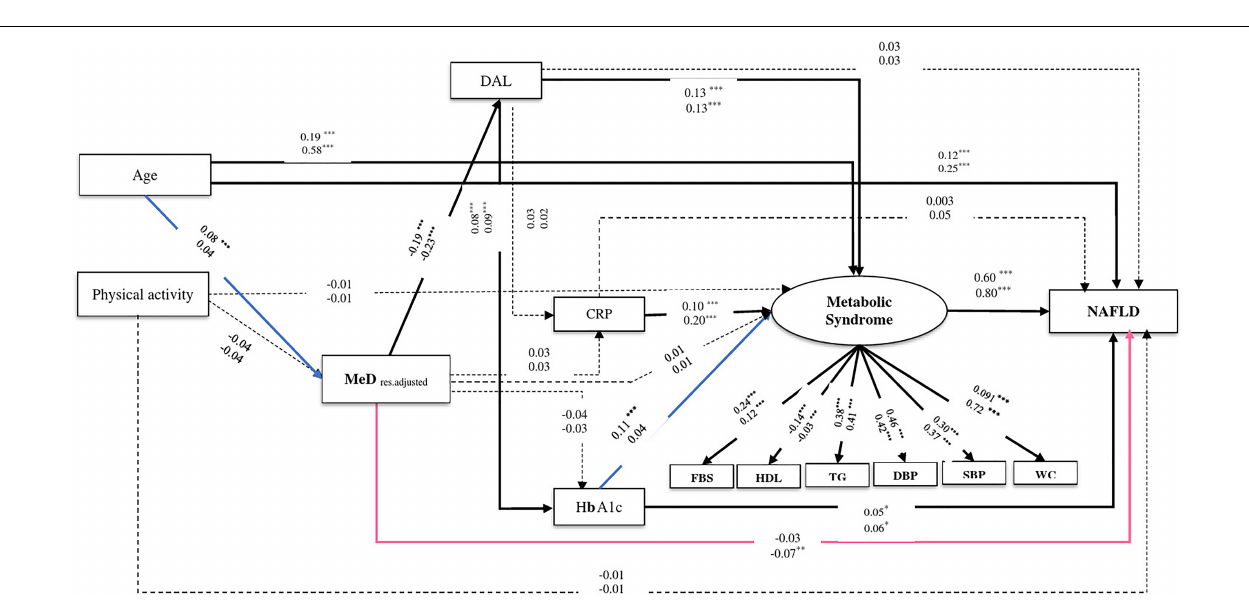
FIGURE 3 | The final structural model of the relationship between residual adjusted DASH and NAFLD. The model fit indices: χ 2 /df = 5.21, P < 0.001, GFI = 0.98, AGFI = 0.96, CFI = 0.95, IFI = 0.95, SRMR = 0.03, RMSEA = 0.03. The values on the paths represent standardized regression coefficients. The upper-faced numbers refer to men, whereas the numerical values below them refer to women. Arrows in bold represent statistically significant associations ( ∗ P < 0.05; ∗∗ P < 0.01; ∗∗∗ P < 0.001). Blue arrows refer to males.